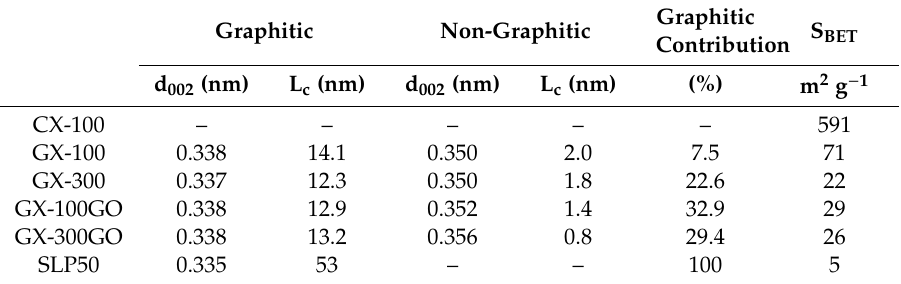
Table 1. Structural properties of the samples.